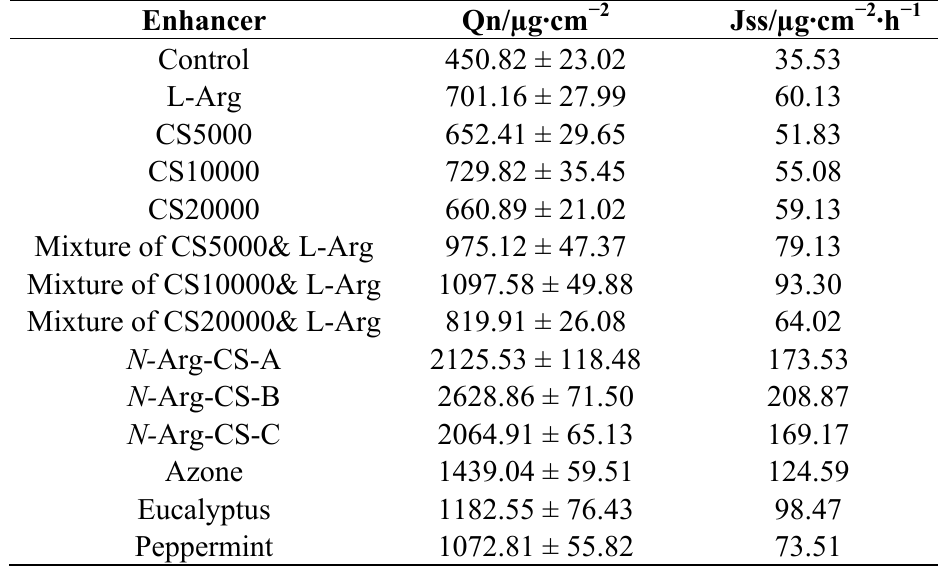
Figure 4. The accumulated transportation of adefovir across mice skins with various enhancers after 12 h (n =